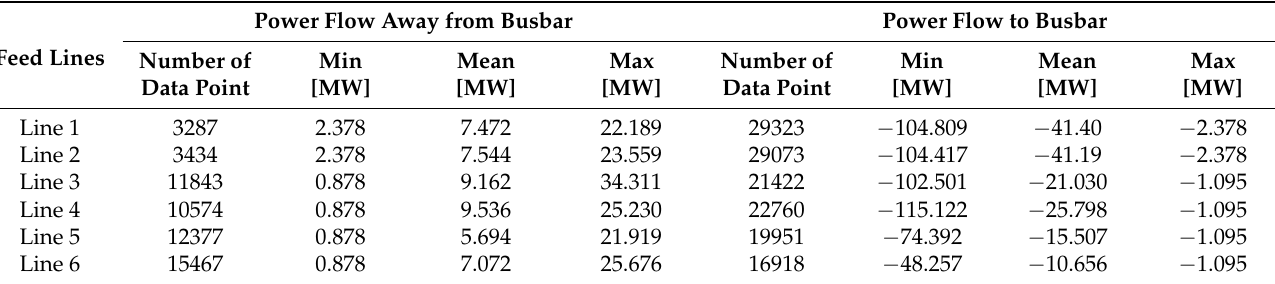
Figure 7. Power flow in all lines of network cluster. Table 4. Statistical description of the power flow measurement